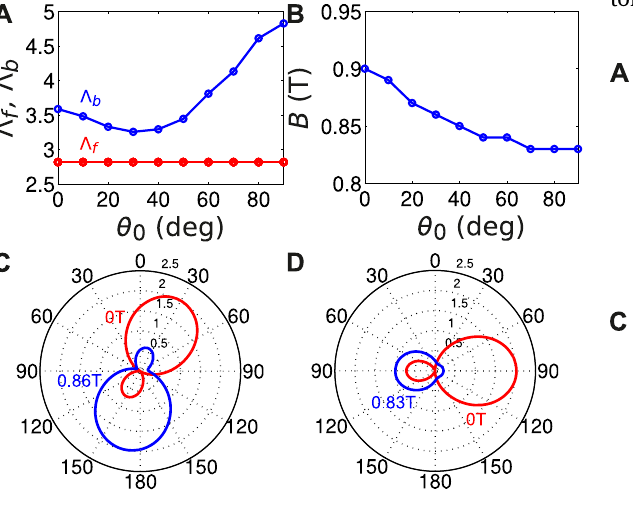
Figure 5: Study of the switching performance under oblique incidence of the impinging plane wave for R 1 / R 2 (cid:2) 0 . 9, while R 2 (cid:2) 10 μ m and λ b / R 2 (cid:2) 8 . 04. The external magnetic fi eld is always z -directed.(A) Ratios Λ f , Λ b versus θ 0 . Red: Λ f ; blue: Λ b . (B)Valuesof B versus θ 0 forachievingpreferentialback-scattering.(C) σ / ( π R 2 2 ) at θ (cid:2) 30 ∘ . Red: forward-scattering at 0 T; blue: back-scattering at 0 ) at θ (cid:2) 90 ∘ . Red: forward-scattering at 0 T; blue: 0.86 T. (D) σ / ( π R 2 0 2 back-scattering at 0.83 T.